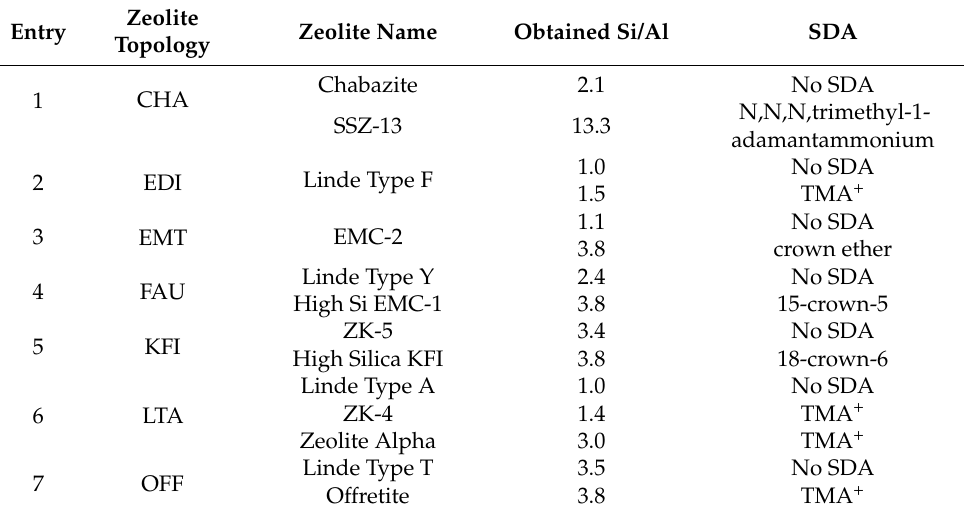
Table 1. Effects of organic SDAs on the Si/Al ratio of synthesized zeolites